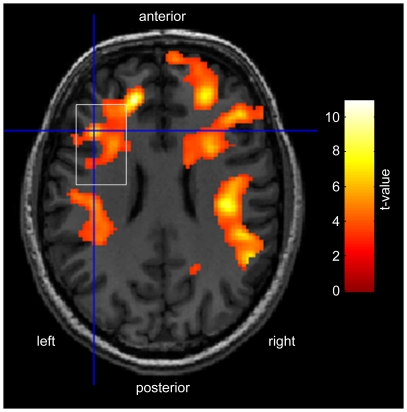
Areas of significant perfusion change during the WM task (p<0.001, uncorrected, k = 150).The location of the left DLPFC voxel (white rectangle) is shown for comparison. Results are presented on an axial slice (MNI z-coordinate = 24) of a T1-weighted image from a single subject.